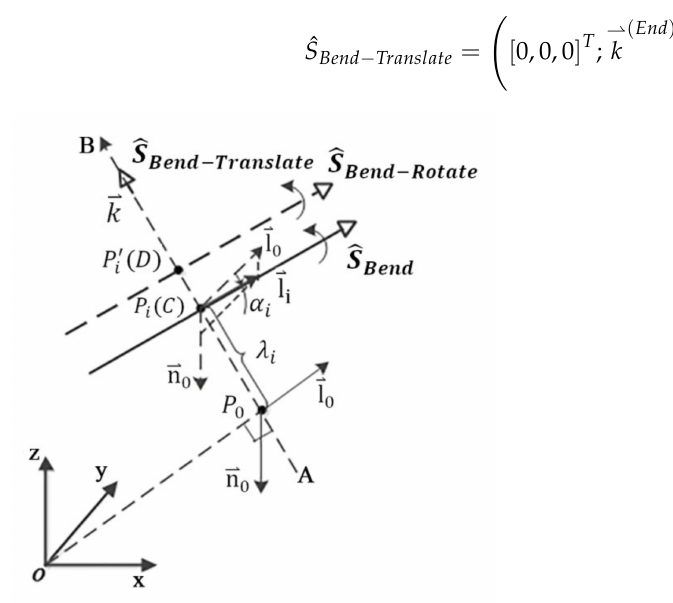
Figure 7. Insert a bend section located in a 3D